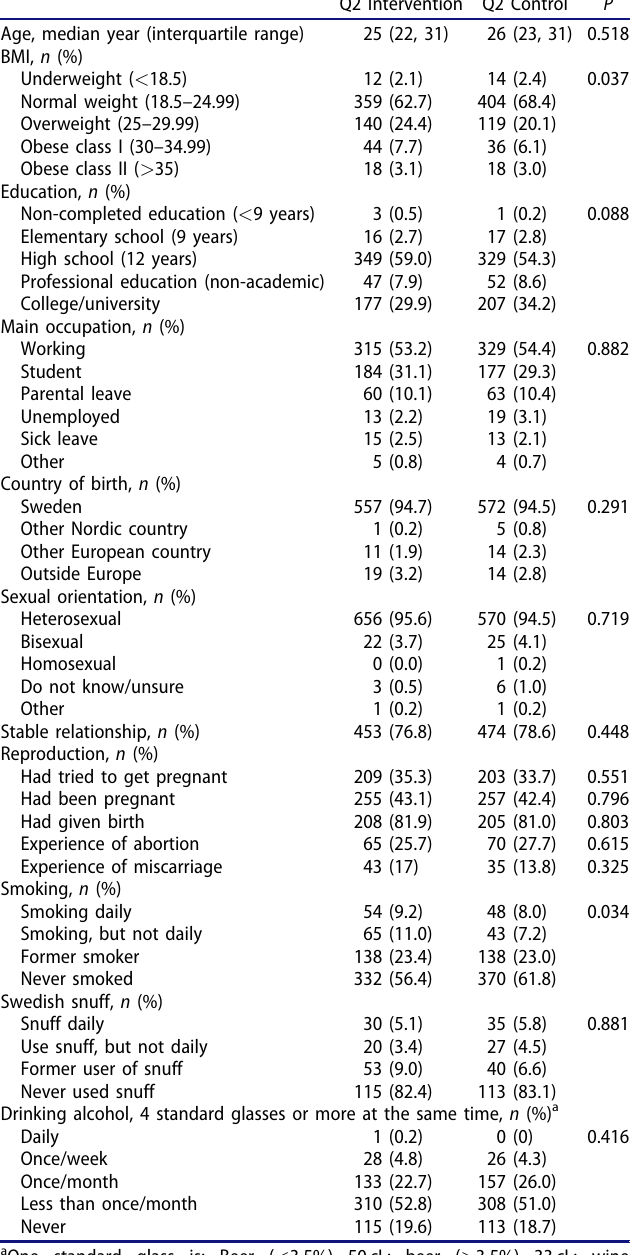
Table 2. Demographic background of study population answering Q2. Q2 Intervention Q2